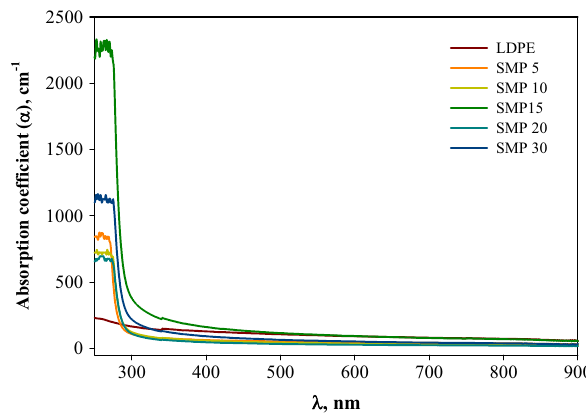
Figure 3: The absorption coe ffi cient vs wavelength of LDPE and grafted LDPE.